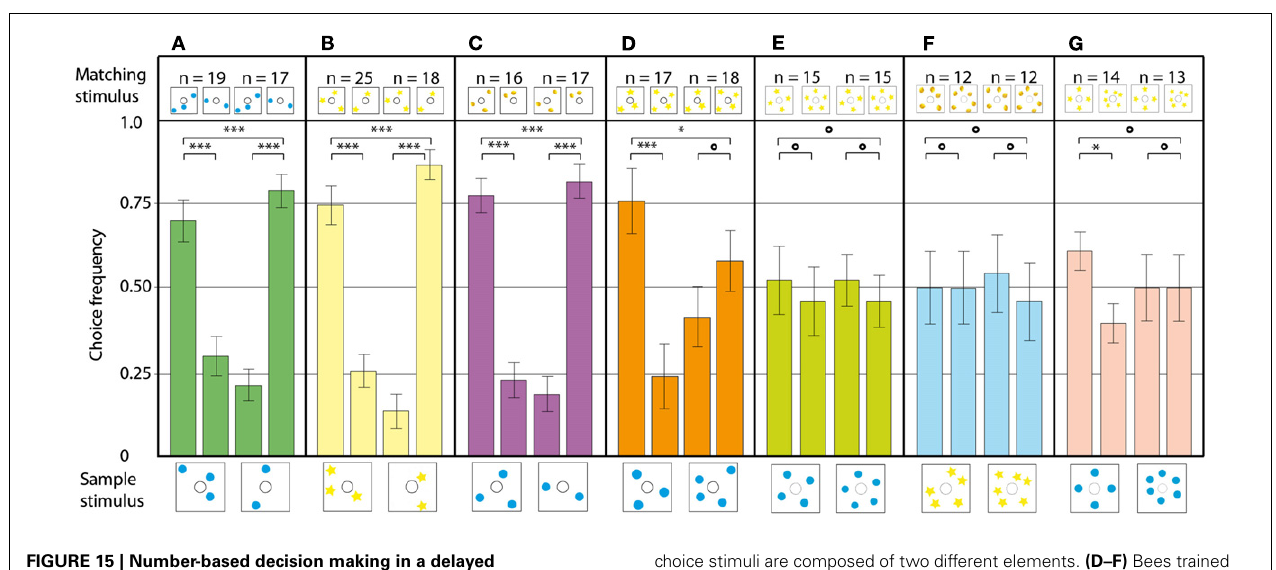
FIGURE 15 | Number-based decision making in a delayed match-to-sample task. The stimulus below each pair of bars is the sample, and that above each bar is the respective choice stimulus.The data present the pooled first choices of individual bees. (A) The configuration of dots on the sample and choice stimuli is randomized. (B) The blue dots are replaced with yellow stars, to see if bees can transfer their matching ability to different, unknown stimuli. (C) The sample and